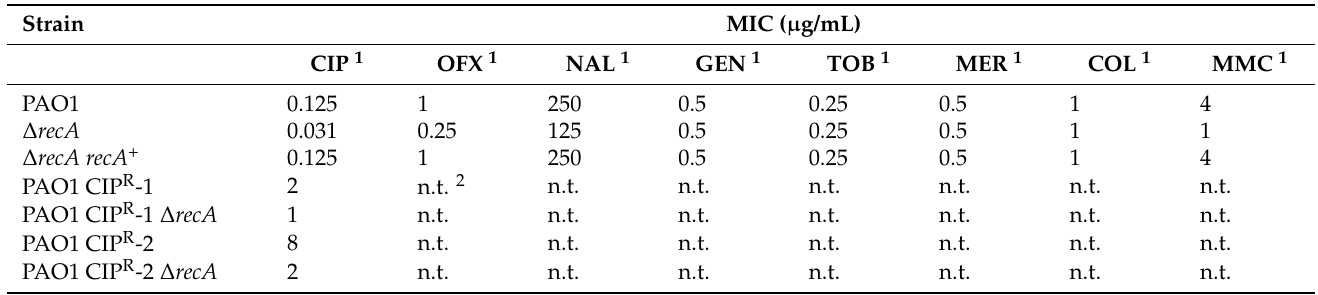
Table 1. MIC of different compounds for the indicated P. aeruginosa